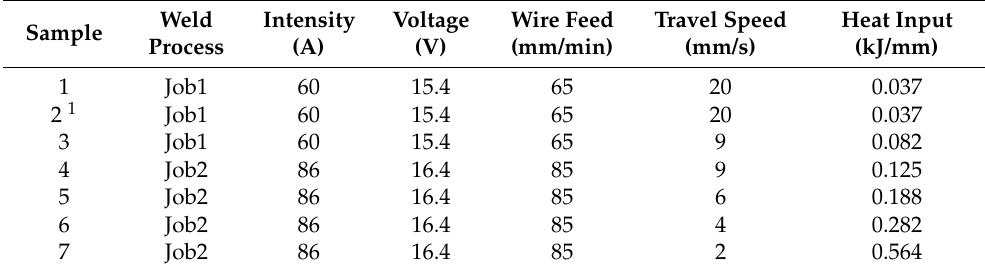
Table 1. Experimental plan of pre-tests.